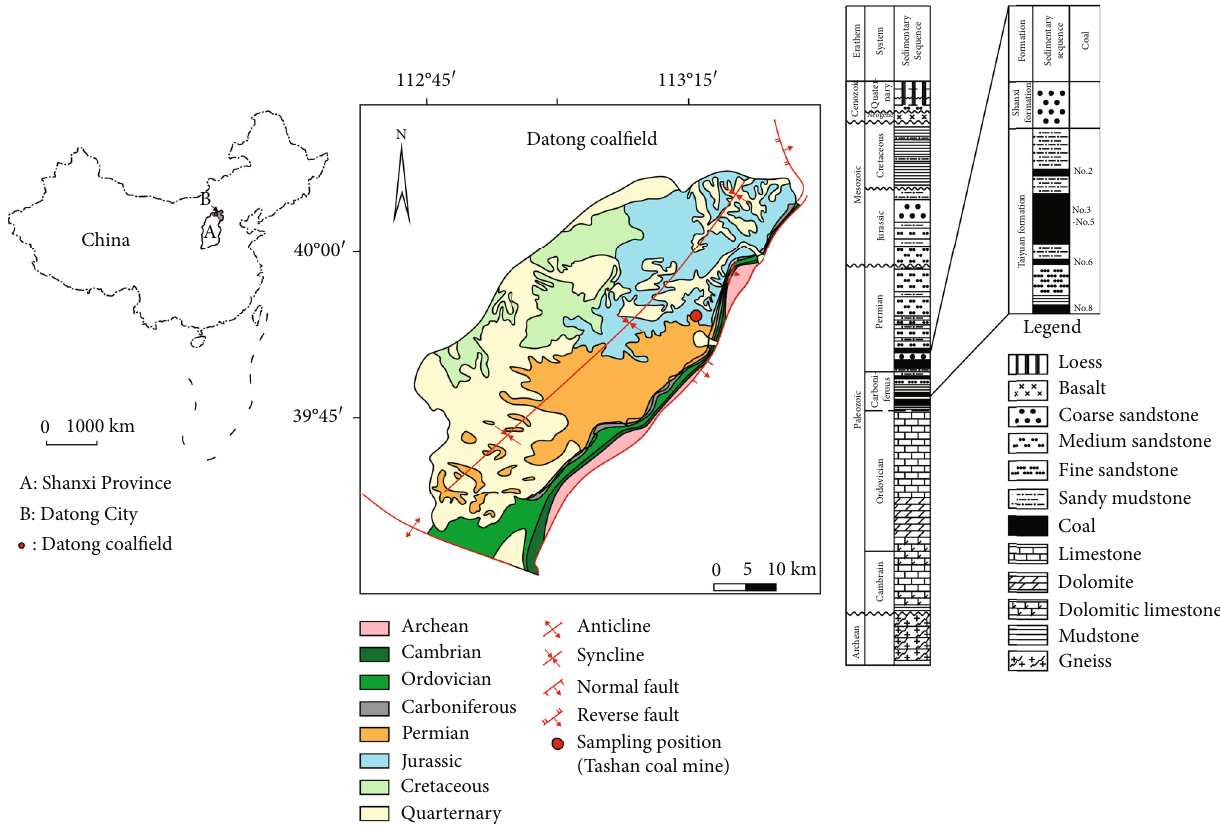
Figure 1: Location, geological map, and generalized stratigraphic column of the Datong coal fi